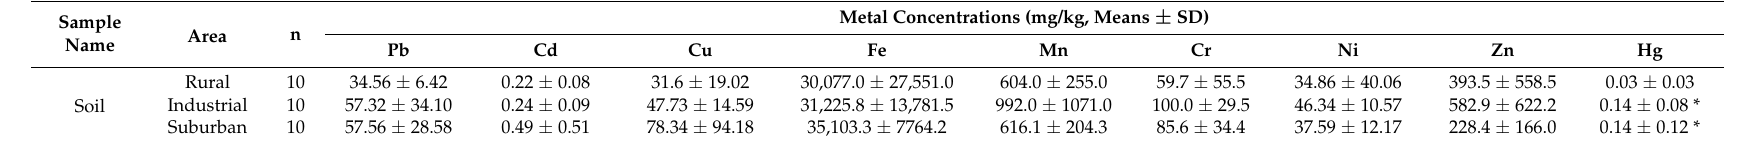
Table 4. Metal concentrations in soil.